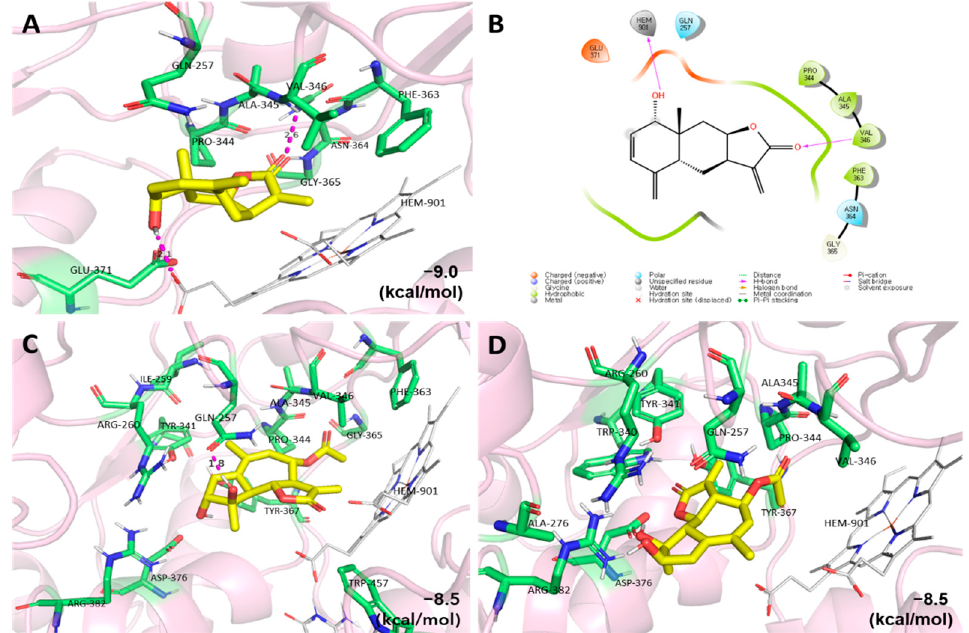
Figure 4. The 3D and 2D diagrams of molecular docking simulations were obtained at the lowest energy conformation (RMSD < 1.0), highlighting potential hydrogen contact for compounds 11 ( A ), 1 ( C ), and 2 ( D ), respectively. Colored by atom: carbon is yellow/green; nitrogen is blue; oxygen is red. For clarity, only the interacting residues are labeled. Hydrogen bonding interactions are shown by dashes. Further analysis of the interactions between iNOS and compound 11 is shown ( B ). Visual illustrations of the interactions were created by PyMOL and Maestro.